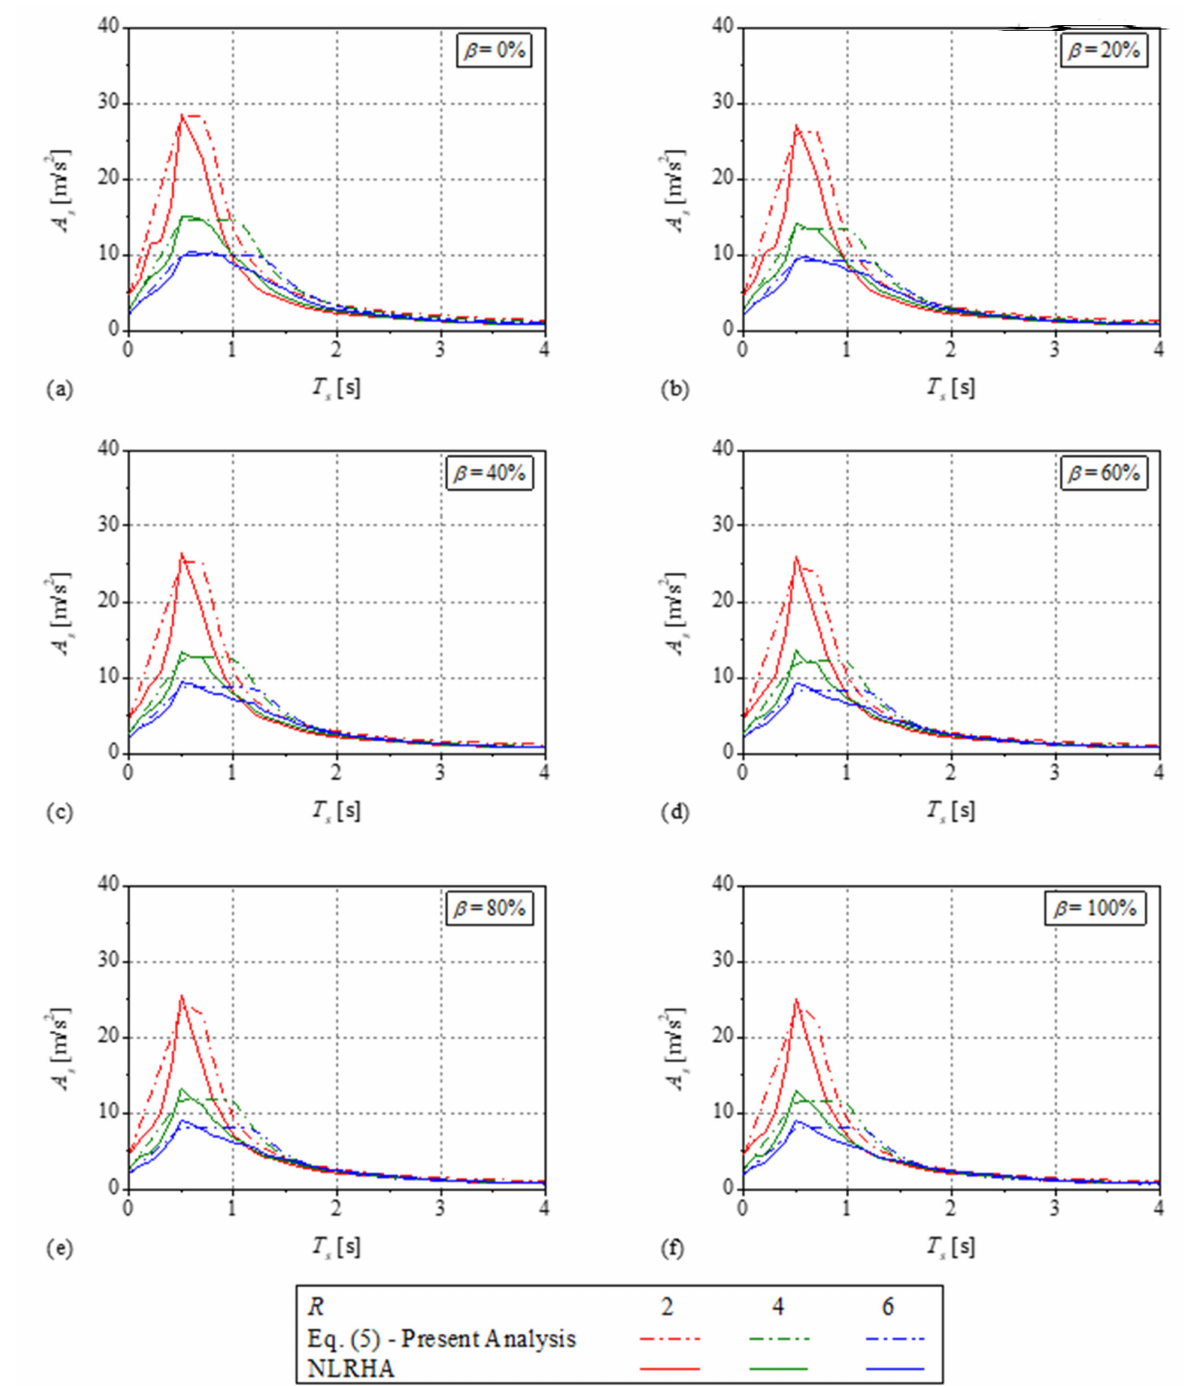
Figure 7. Comparison of the mean floor response spectra from Equation (5) and NLRHA for a primary structure with initial vibration period T p = 0.5 s, post-yield stiffness ratio α = 5%; viscous damping ratio ξ p = 5%; and a secondary structure with viscous damping ratio ξ s = 5%: ( a ) β = 0%; ( b ) β = 20%; ( c ) β = 40%; ( d ) β = 60%; ( e ) β = 80%; and ( f ) β =